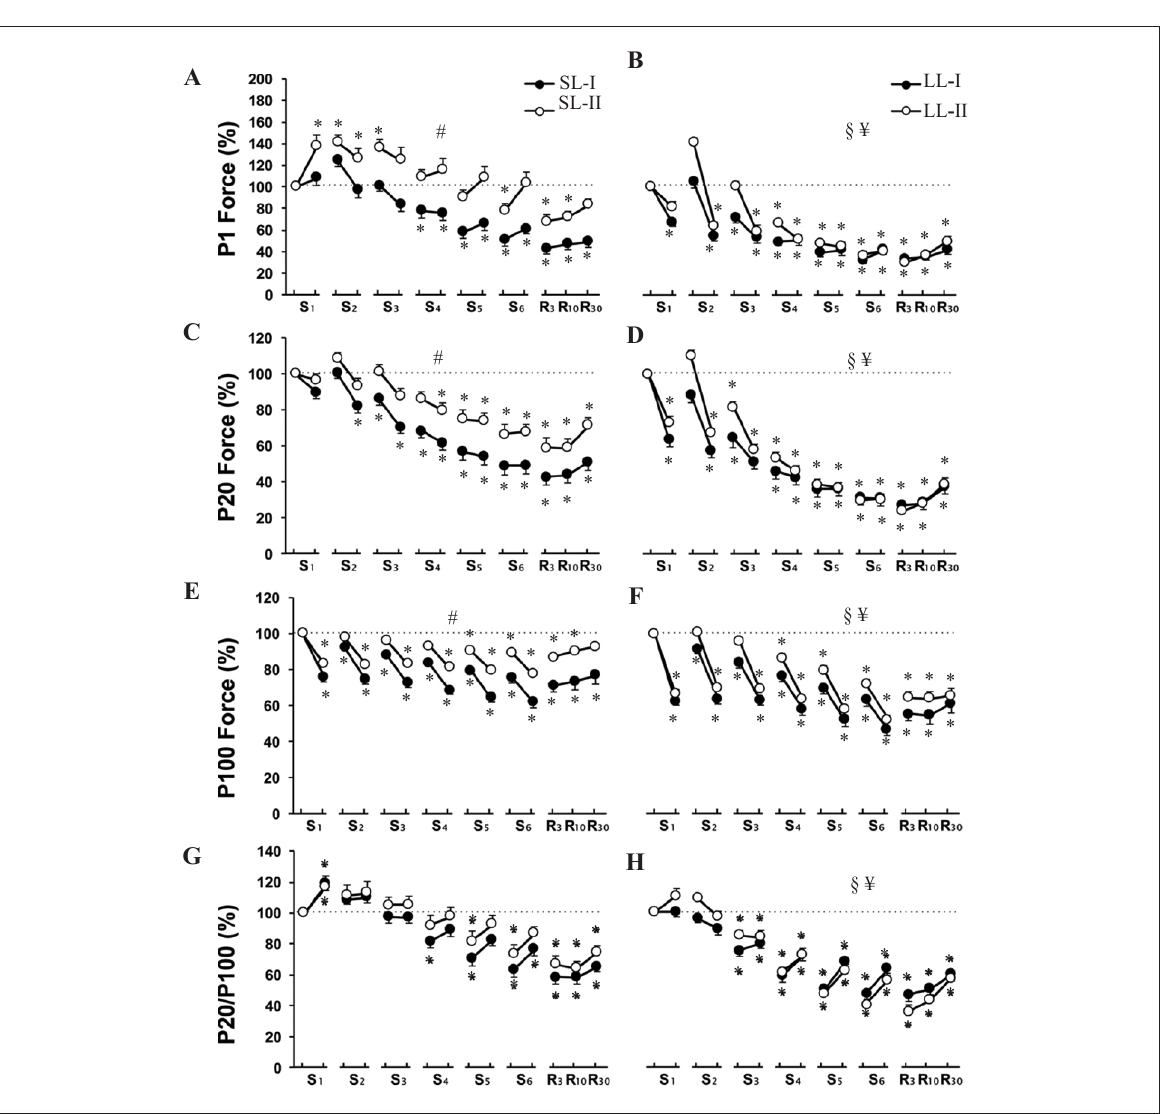
Figure 3. Electrostimulation (non-voluntary contraction) results after each series of sustained maximal (uni-)bilateral contraction